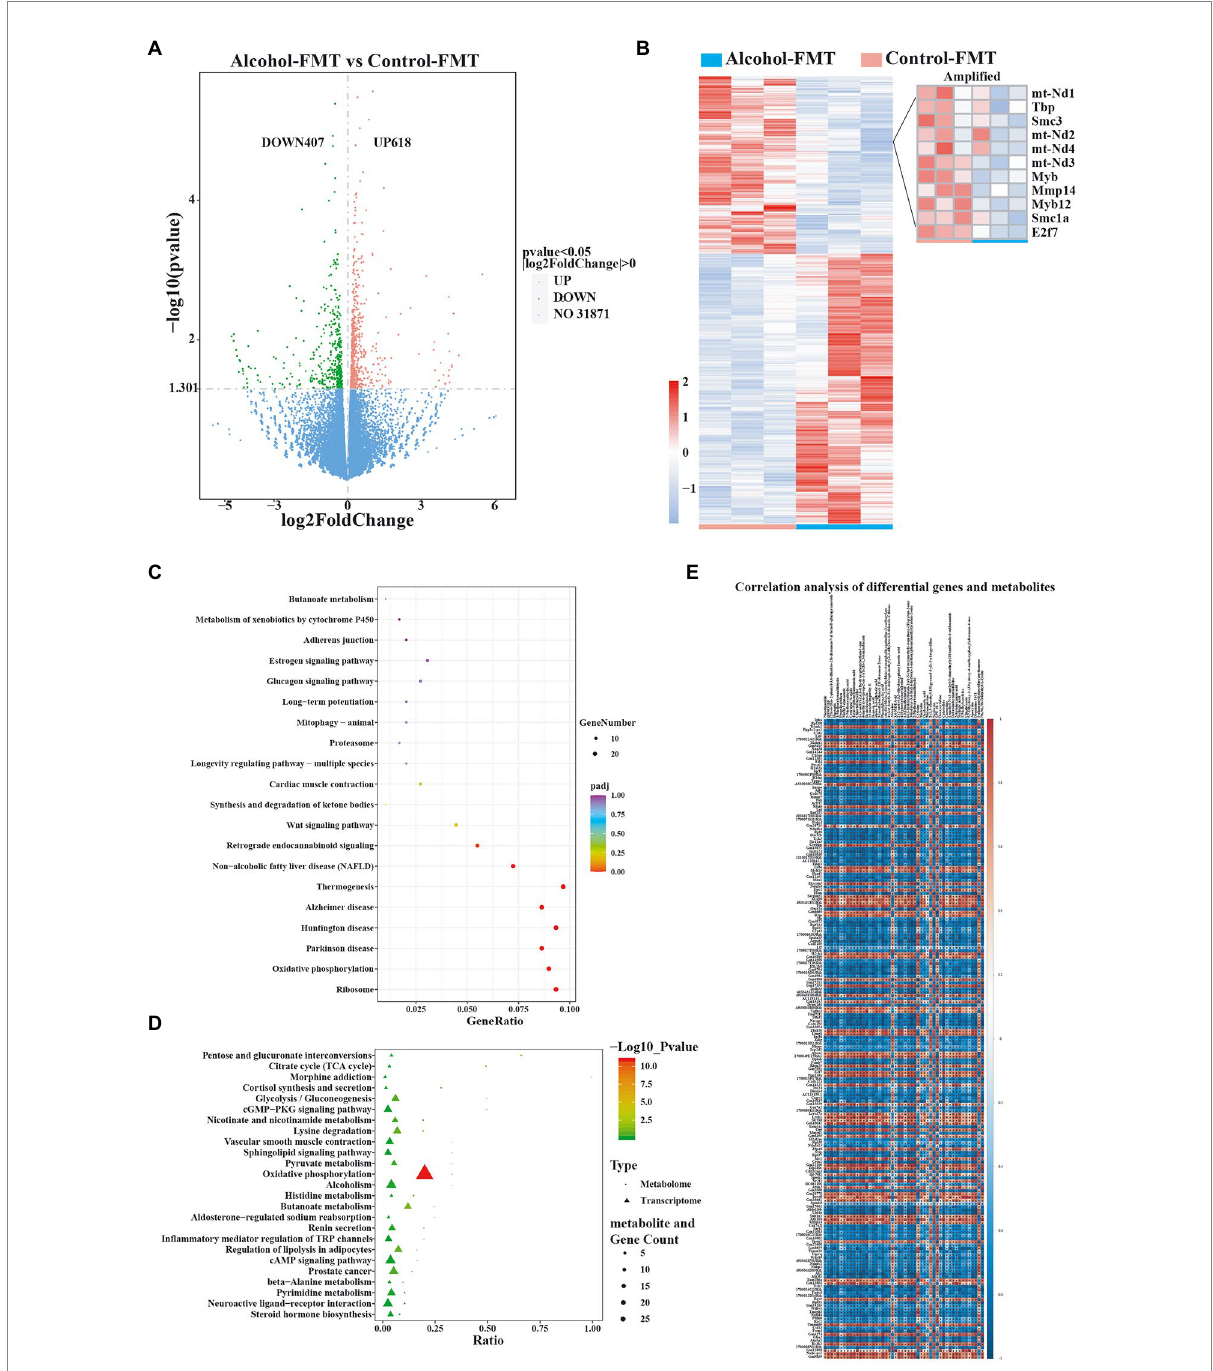
FIGURE 6 Alterations in gene expression in alcohol-FMT-treated testes. (A) Volcano plot showing the changes in the expression of testis-related genes ( p value<0.05). (B) Heatmap of differentially expressed genes in the testis. (C) KEGG pathway enrichment analysis of differentially expressed genes. (D) The KEGG coenrichment bubble map was drawn using the common enriched pathways of differentially altered metabolites and differentially expressed genes. (E) Correlation analysis of differentially expressed genes and metabolites. The results of the correlation analysis showing the top 50 differentially altered metabolites ( p -values ranging from low to high) and the top 100 differentially expressed genes ( p values ranging from low to high). Red represents a positive correlation, blue represents a negative correlation, and a darker color corresponds to a stronger correlation. * p < 0.05 and ** p <